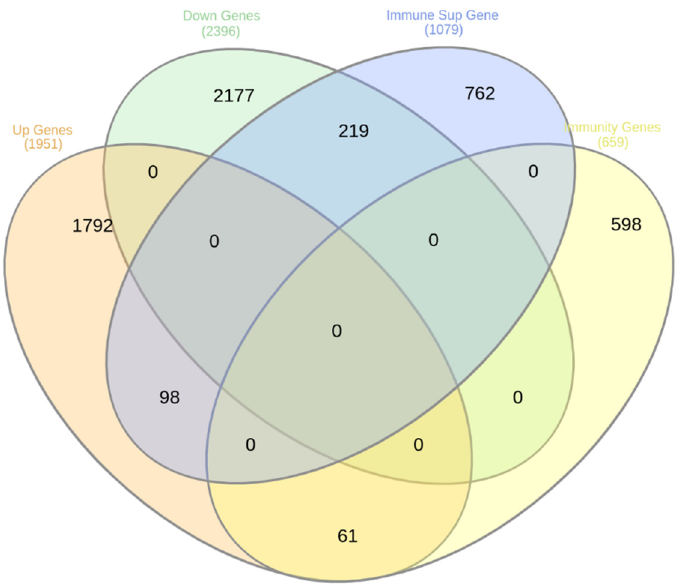
Figure 4. Venn diagram between DEGs of comparison-I with gene set-2 (immune suppressor) and gene set-1 immunity related genes.